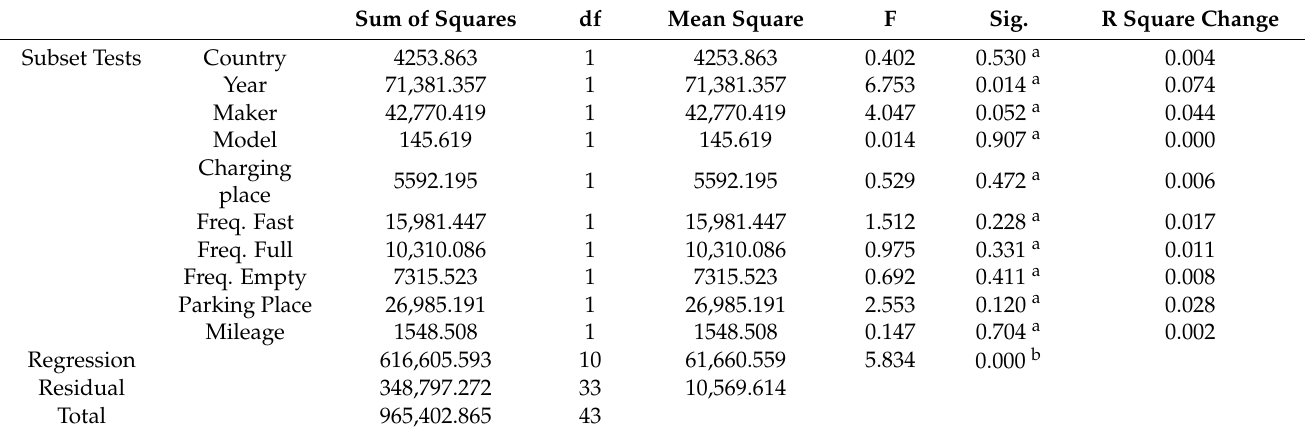
Table 7. Analysis of Variance test—ANOVA—Variable: Max range